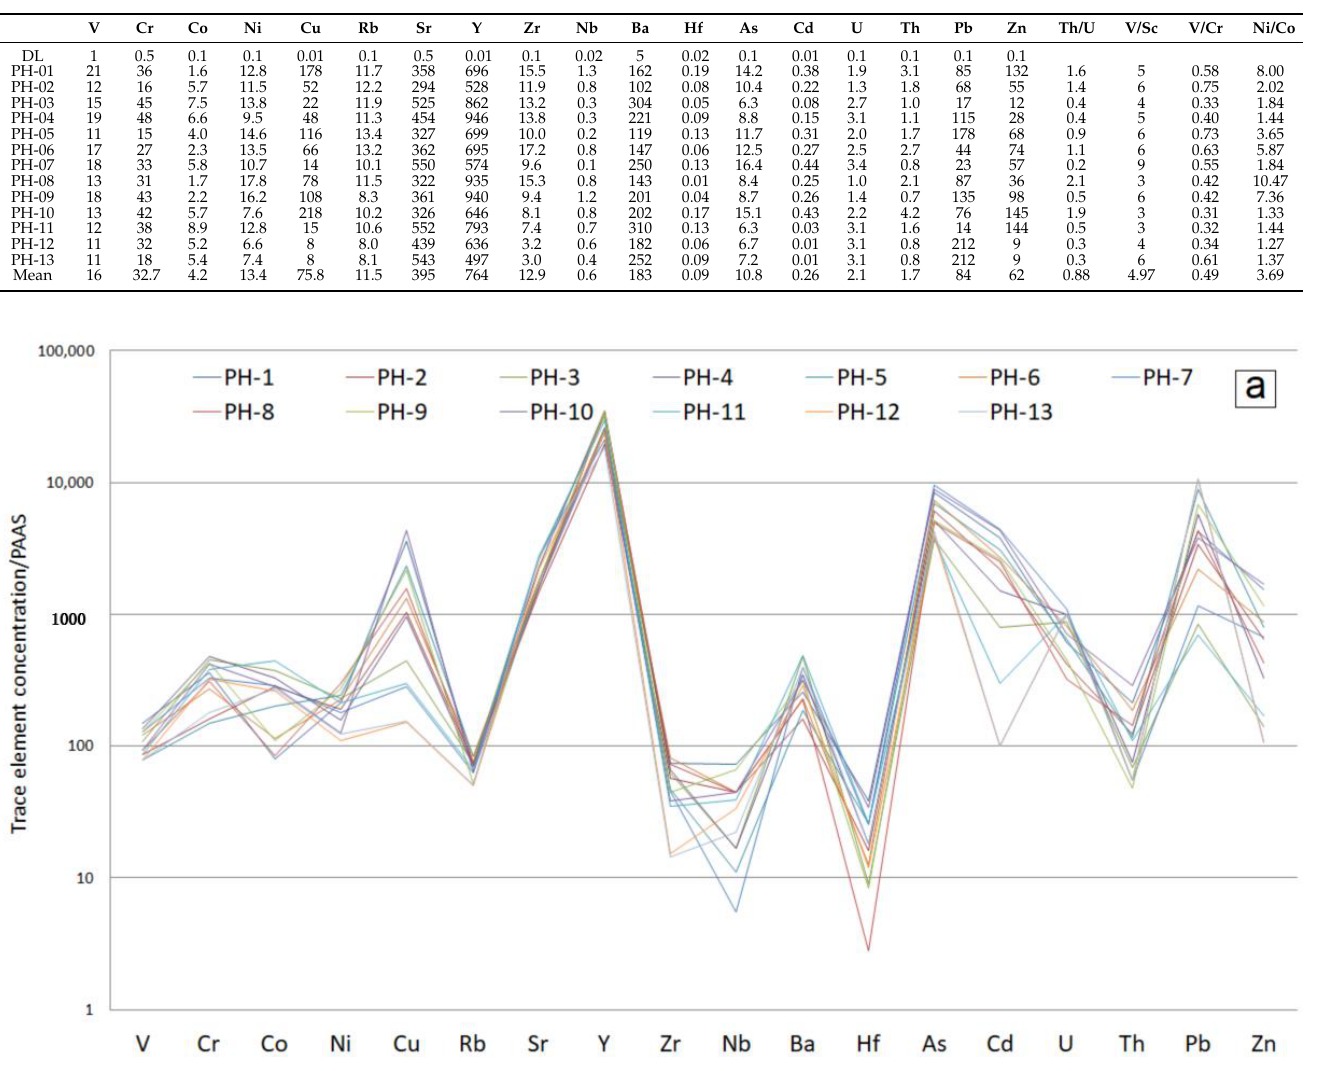
Table 3. Trace element concentrations (ppm) of the phosphate nodules.